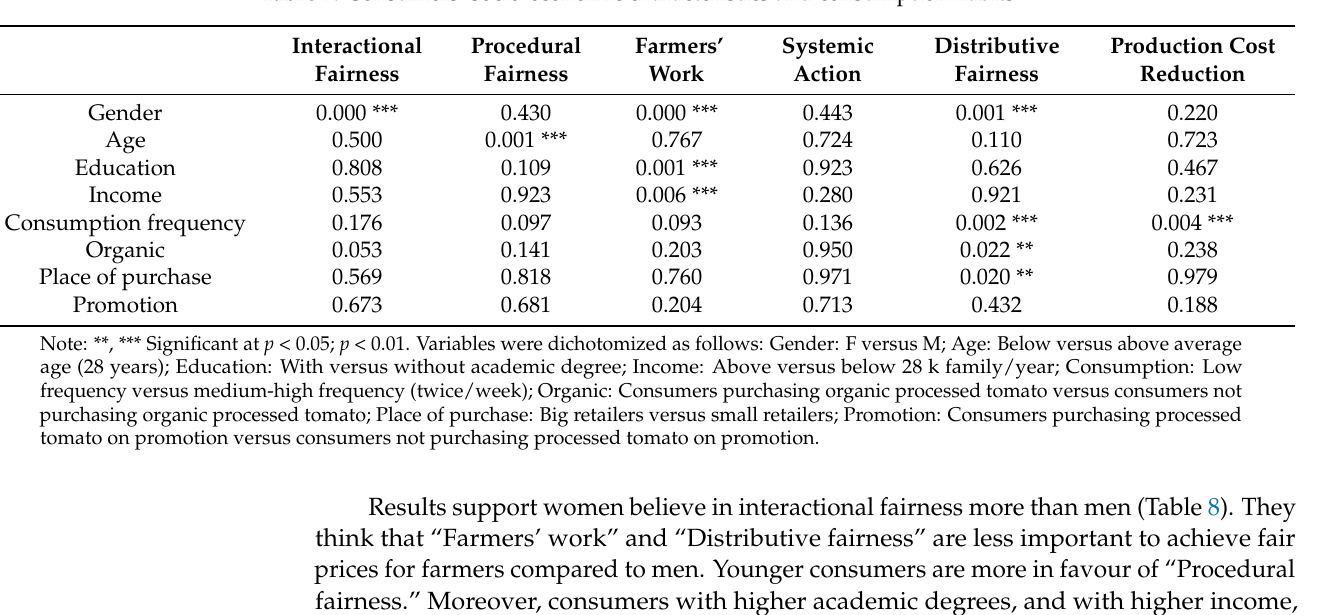
Table 7. Consumers’ socio-economic characteristics and consumption habits.